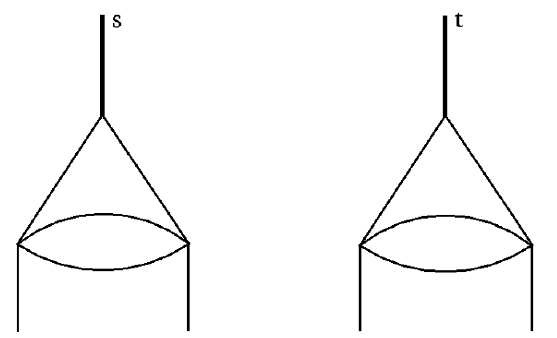
Figure 6 . The master integrals determined by crossed double cut as depicted in the right-hand (cid:12)gure in (cid:12)gure